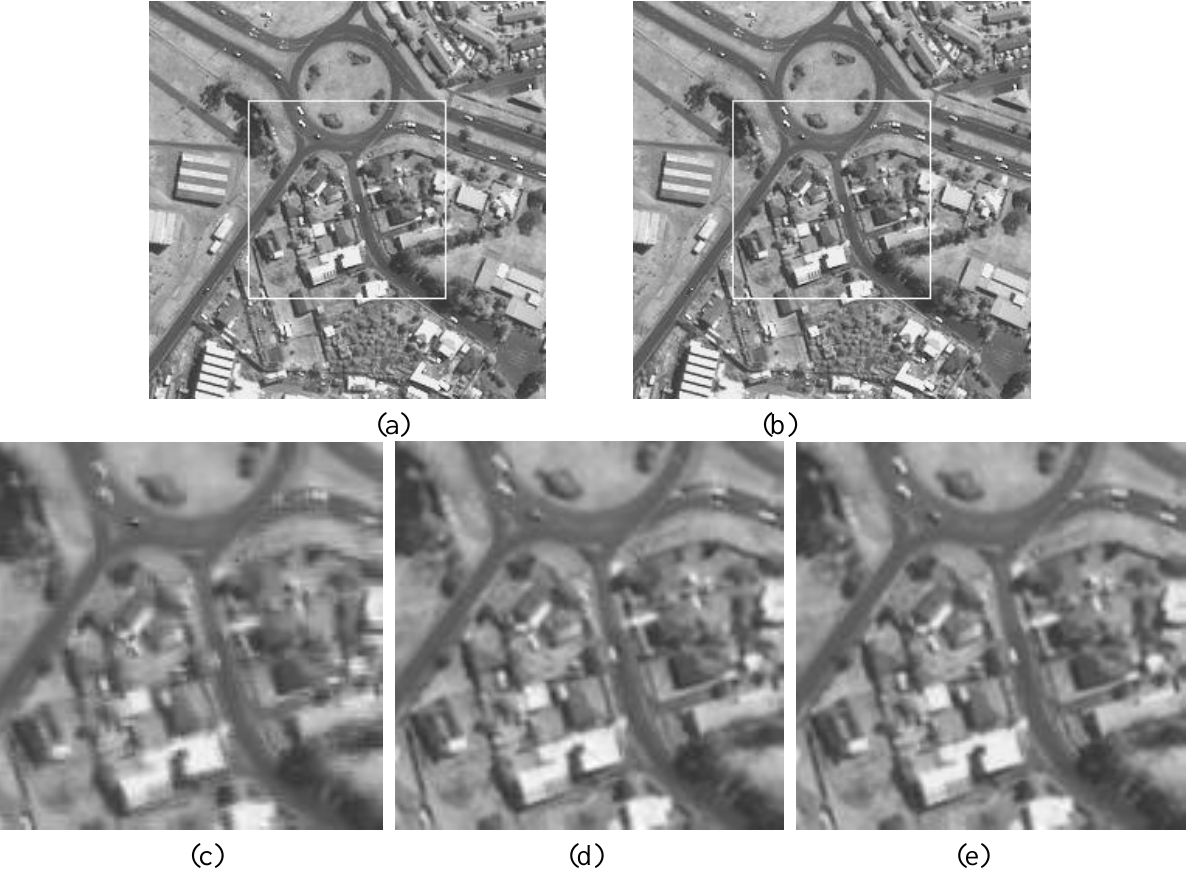
Figure 8. Registration of IKONOS images obtained using the three approaches: (a) the reference image, (b) the transformed image, (c) registered image using wavelet, (d) registered image using the first proposed method, and (e) registered image using the second proposed method.